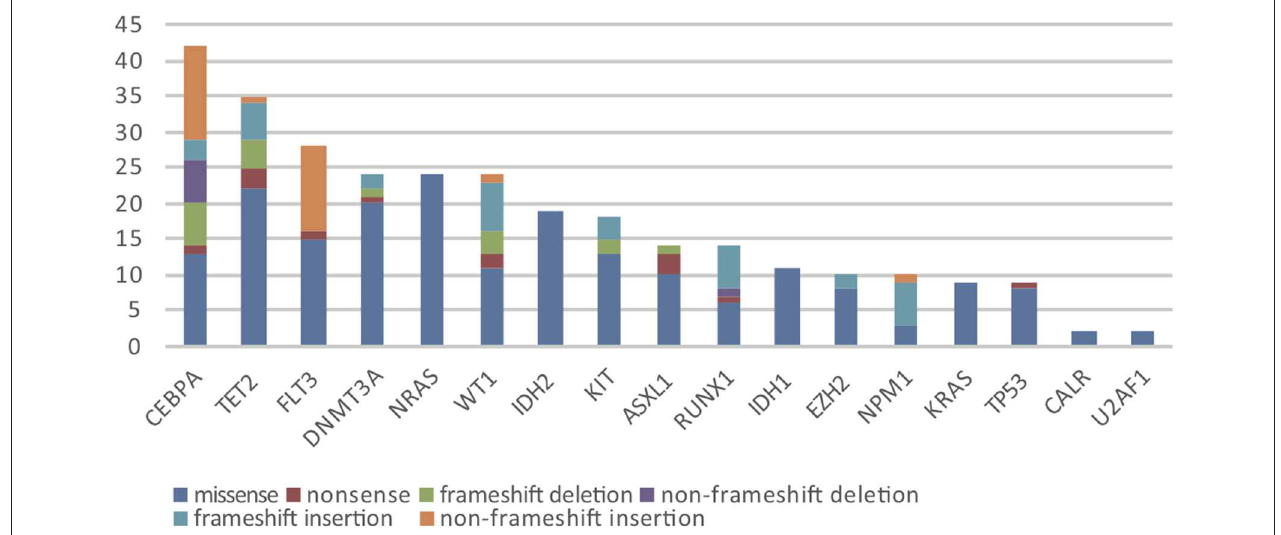
FIGURE 1 | The number and subtype distribution of the 17 gene variants included in the AML NGS panel. Each variant subtype is marked with a unique color. Y axis represents the variant number (N) of each gene.